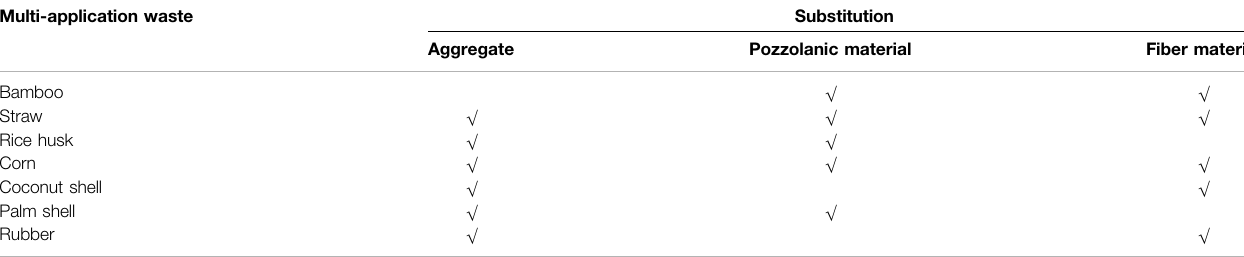
TABLE 4 | Alternative application of multi-application